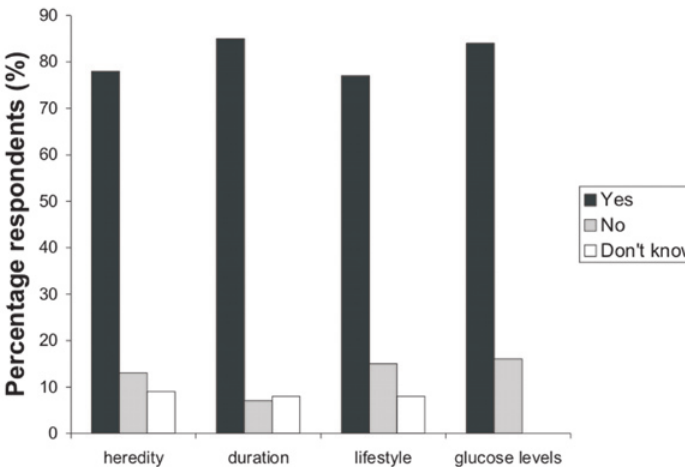
Figure 1: Percentages of respondents’ knowledge regarding the risk factors for the development of DM and its